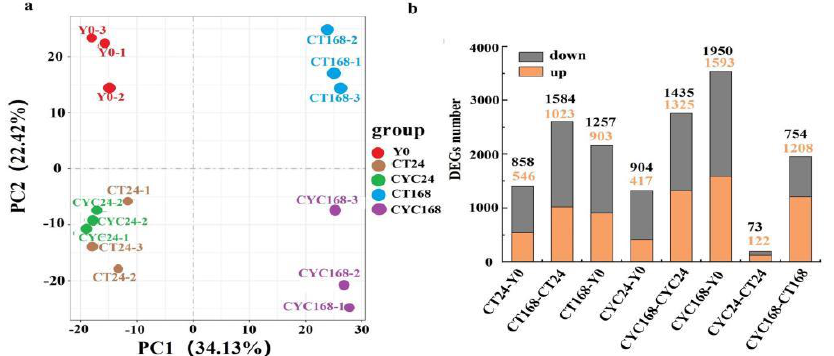
Figure 4. Principle component analysis and differentially expressed genes count. ( a ) Principle component analysis of controls and treatment samples at 0, 24 and 168 h. ( b ) the numbers of differentially expressed genes from all sample comparisons at different time points after treatment.